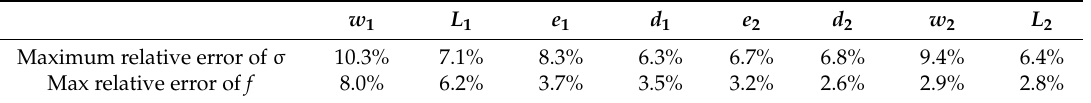
Table 3. The maximum relative errors.